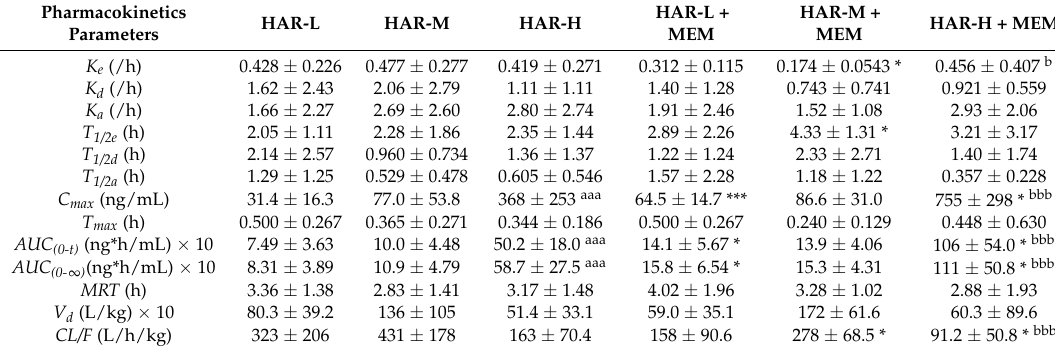
Table 2. Pharmacokinetics parameters of HAR in rats plasma after oral administration of low (20.0 mg/kg), medium (40.0 mg/kg) and high (80.0 mg/kg) doses of HAR and low (20.0 mg/kg), medium (40.0 mg/kg) and high (80.0 mg/kg) doses of HAR combined with MEM (5.0 mg/kg) (n = 8, mean ± SD).